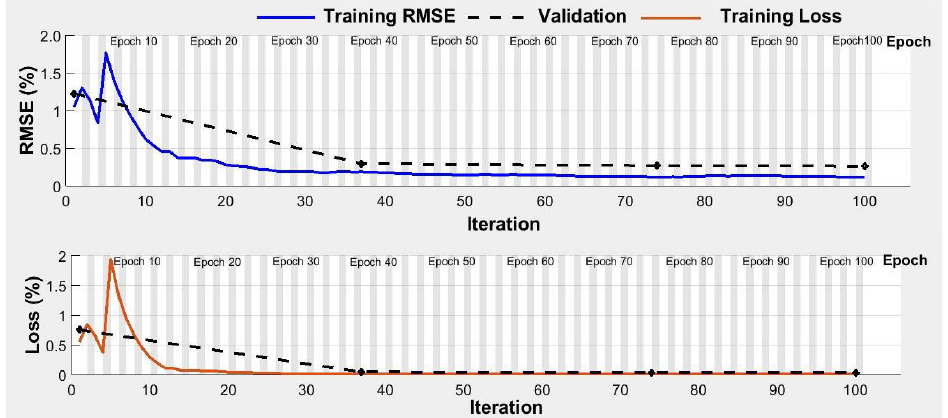
Figure 8. Accuracy and loss corves for Long Short Term memory based deep learning model for crop water stress identification.